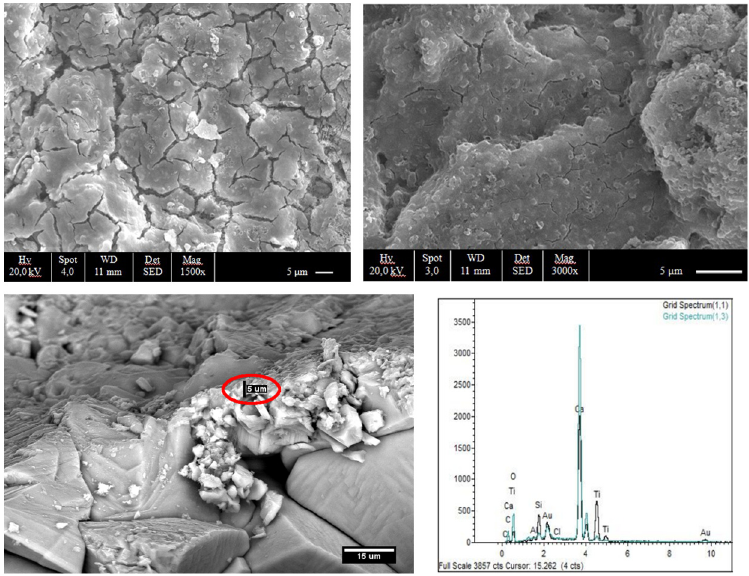
Figure 2. Scanning electron microscopy/energy dispersive X-ray spectroscopy (SEM/EDX) analysis of treated samples: surface morphology (SED, magnitude 1500× and 3000×); cross-section (BSD, titanium is colored bright white) with a reference scale for measuring the thickness of the coating and EDX spectra (two different measurement points). Details